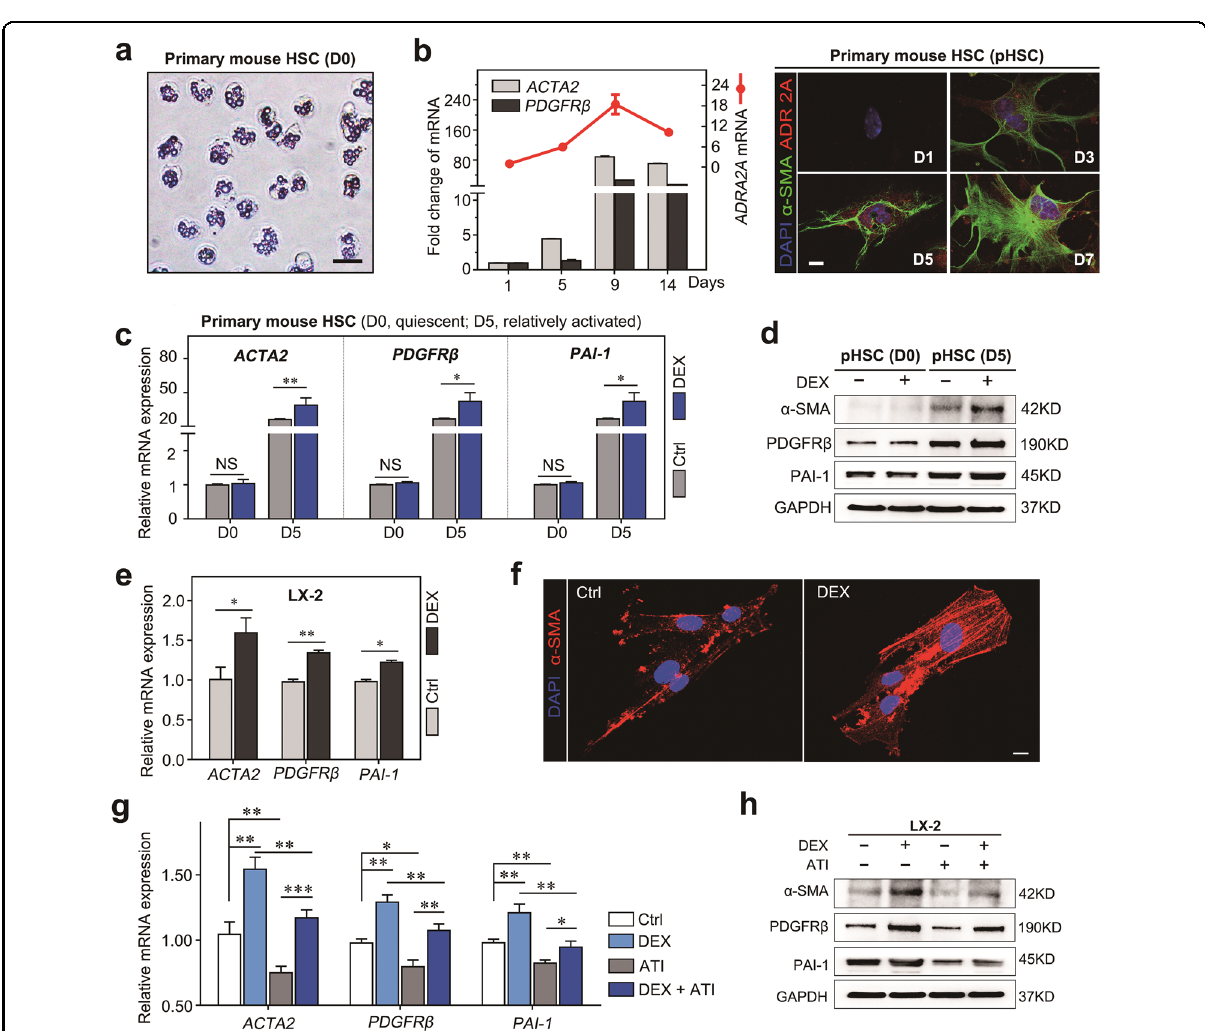
Fig. 4 DEX enhanced the activation of aHSCs but had no signi fi cant effect on quiescent HSCs. a Representative image of freshly isolated HSCs from C57/BL mice. Merging of the retinoid fl uorescence image with the phase-contrast image shows complete overlap of the retinoid signal with characteristic lipid droplets. b The left panel shows fold changes in ADRA2A , ACTA2 , and PDGFR β mRNA expression in primary HSCs isolated from normal mouse livers cultured for the indicated time intervals. The right panel shows gradually increasing protein levels of ADRA2A and α -SMA in primary HSCs isolated from normal mouse liver cultured for the indicated time intervals. c ACTA2 , PDGFR β , and PAI-1 mRNA level changes in D0 cells (quiescent HSCs) and D5 cells (partially aHSCs) cultured with DEX (10 μ M). d ACTA2, PDGFR β , and PAI-1 protein level changes in D0 cells (quiescent HSCs) and D5 cells (relatively aHSCs) cultured with DEX (10 μ M). e ACTA2 , PDGFR β , and PAI-1 mRNA level changes in LX-2 cells treated with DEX. f Immuno fl uorescence staining of α -SMA in LX-2 cells treated with DEX (10 μ M). g ACTA2 , PDGFR β , and PAI-1 mRNA level changes in LX-2 cells treated with DEX, ATI (atipamezole), or the combination. h Changes in ACTA2, PDGFR β , and PAI-1 protein levels in LX-2 cells treated with DEX, ATI, or the combination. Data are presented as the mean ± SD. * P < 0.05; ** P <